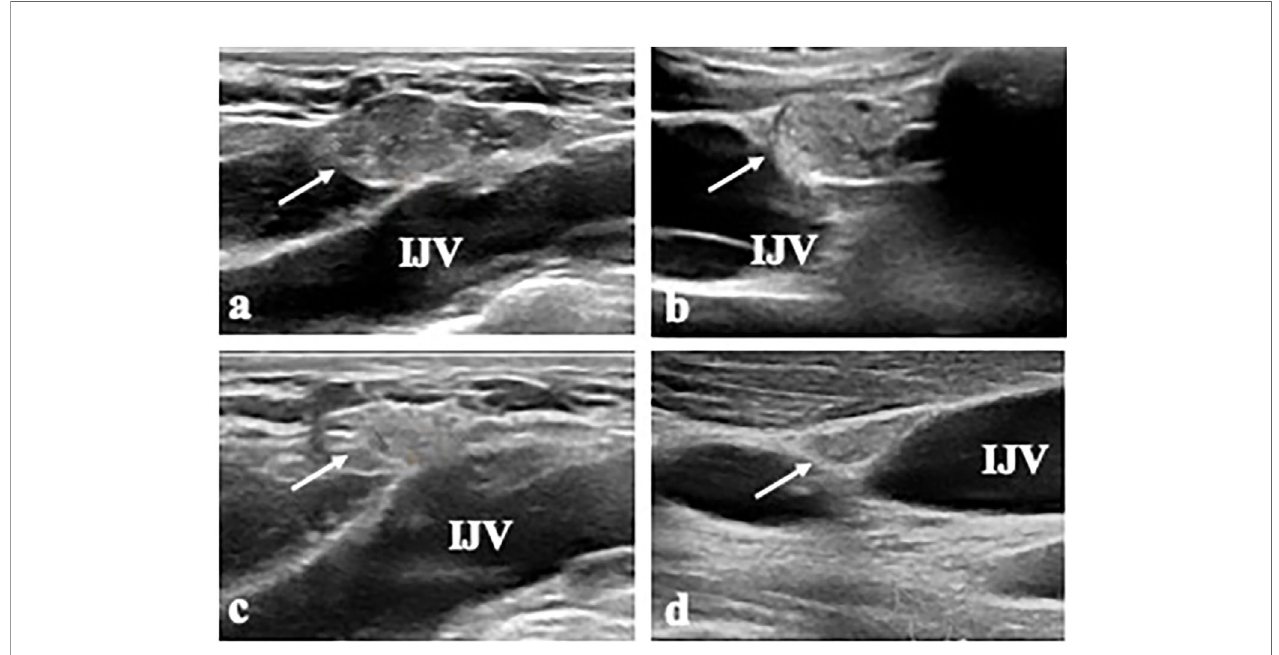
FIGURE 2 | A 17-year-old male patient (Patient 4) with metastatic LN (LN 7) at left level IV. (A, B) The transverse and longitudinal US shows a 2.0-cm-sized hypoechoic mass (arrow) near the internal jugular vein (IJV) at left level IV. (C, D) At 15 months after RFA, the transverse and longitudinal US shows the ablated LN is decreased in size